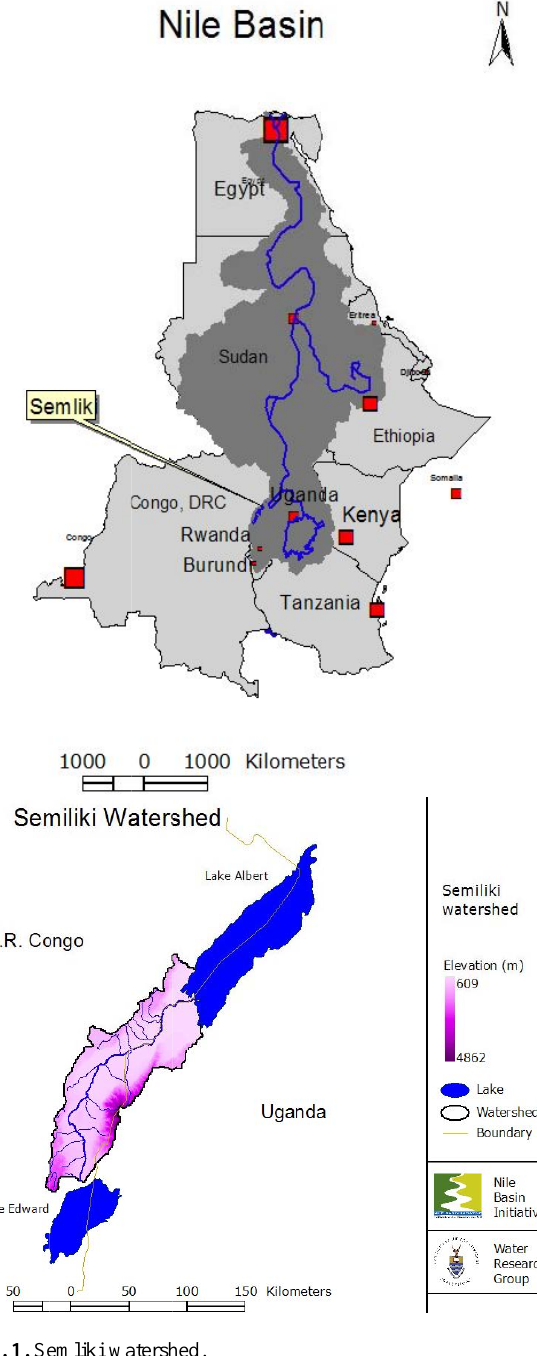
Figu Figuure 1: Sem Semmliki waters Subcahed